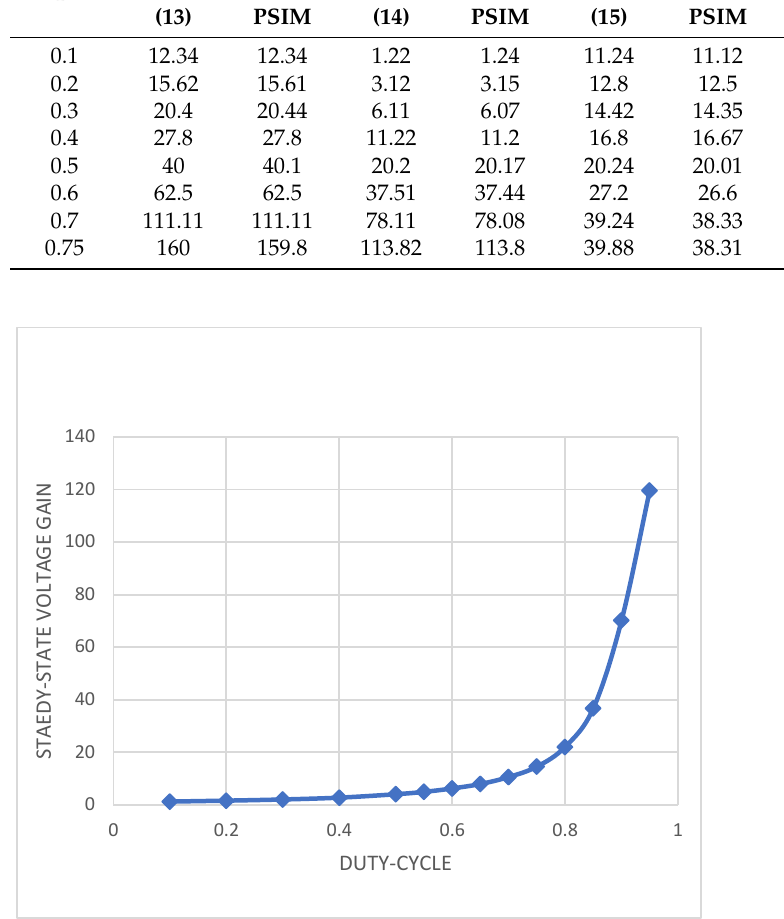
Figure 7. Steady-state voltage gain vs. duty-cycle response. A 250 Watts prototype of the proposed boost converter with a 50 kHz switching fre- quency was configured for the most practical parasitic values of the components used in the modeling. These values are given as: the R DS,ON of the MOSFET was set to 0.02 Ω , the forward voltage drop for each diode was set to 0.6 V, ESR for each capacitor was set to 0.001 Ω , and the series resistance for each inductor coil was set to 0.1 Ω .